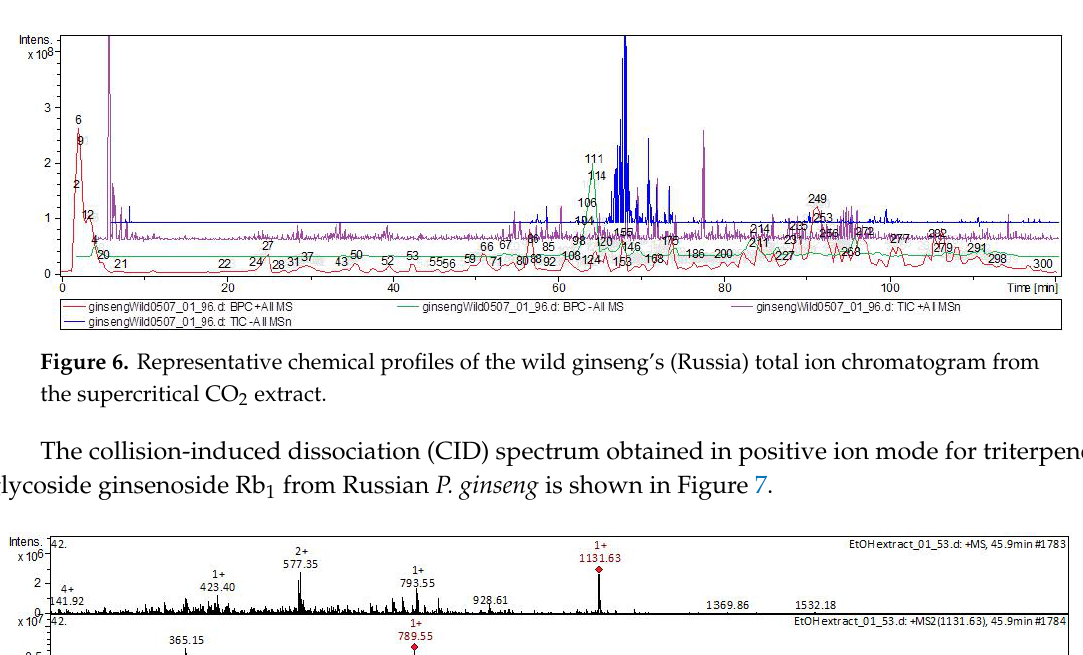
Figure 5. The distribution density of the analyzed chemical profiles in the ion chromatogram of the wild ginseng supercritical CO 2 extract (Russia).